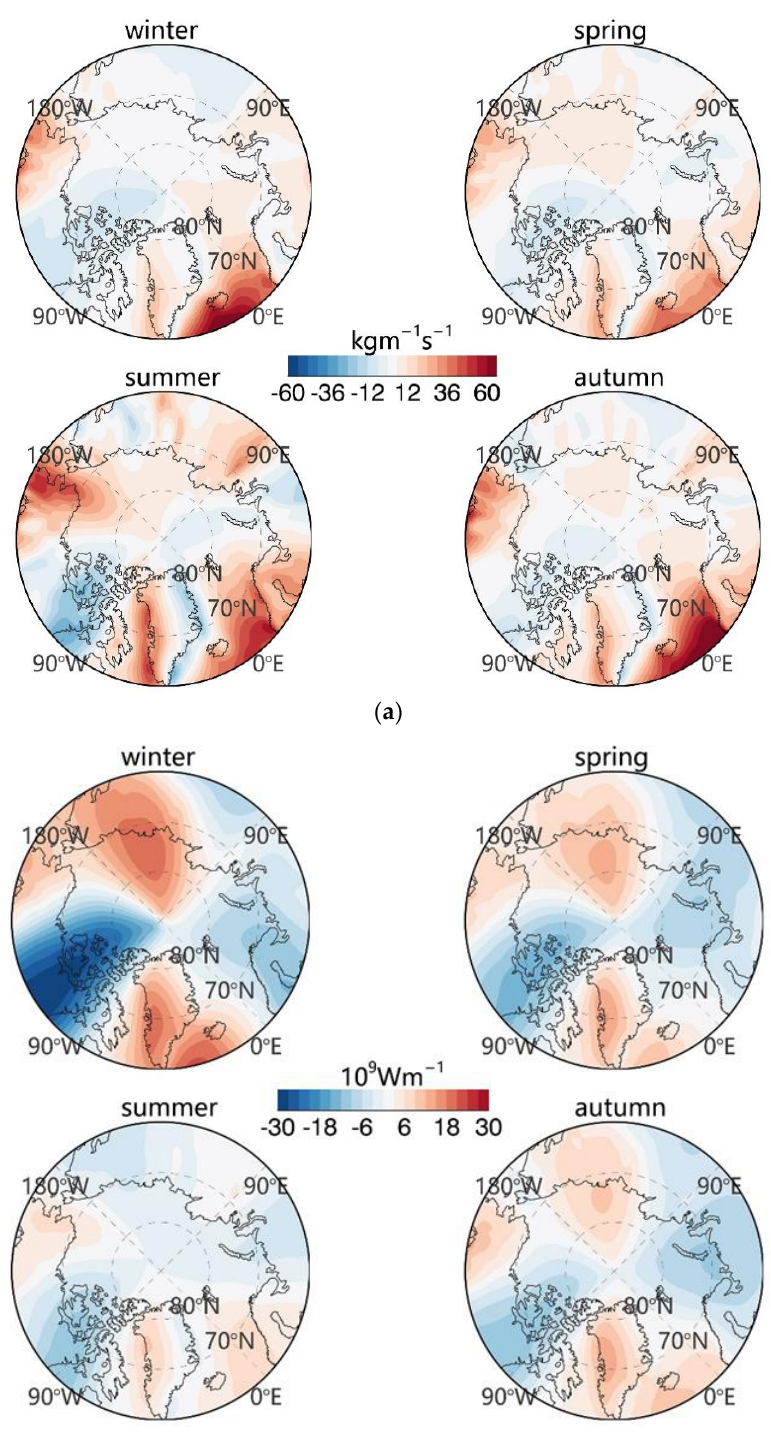
Figure 2. Spatial distribution of meridional ( a ) moisture fluxes and ( b ) total energy fluxes across 70°